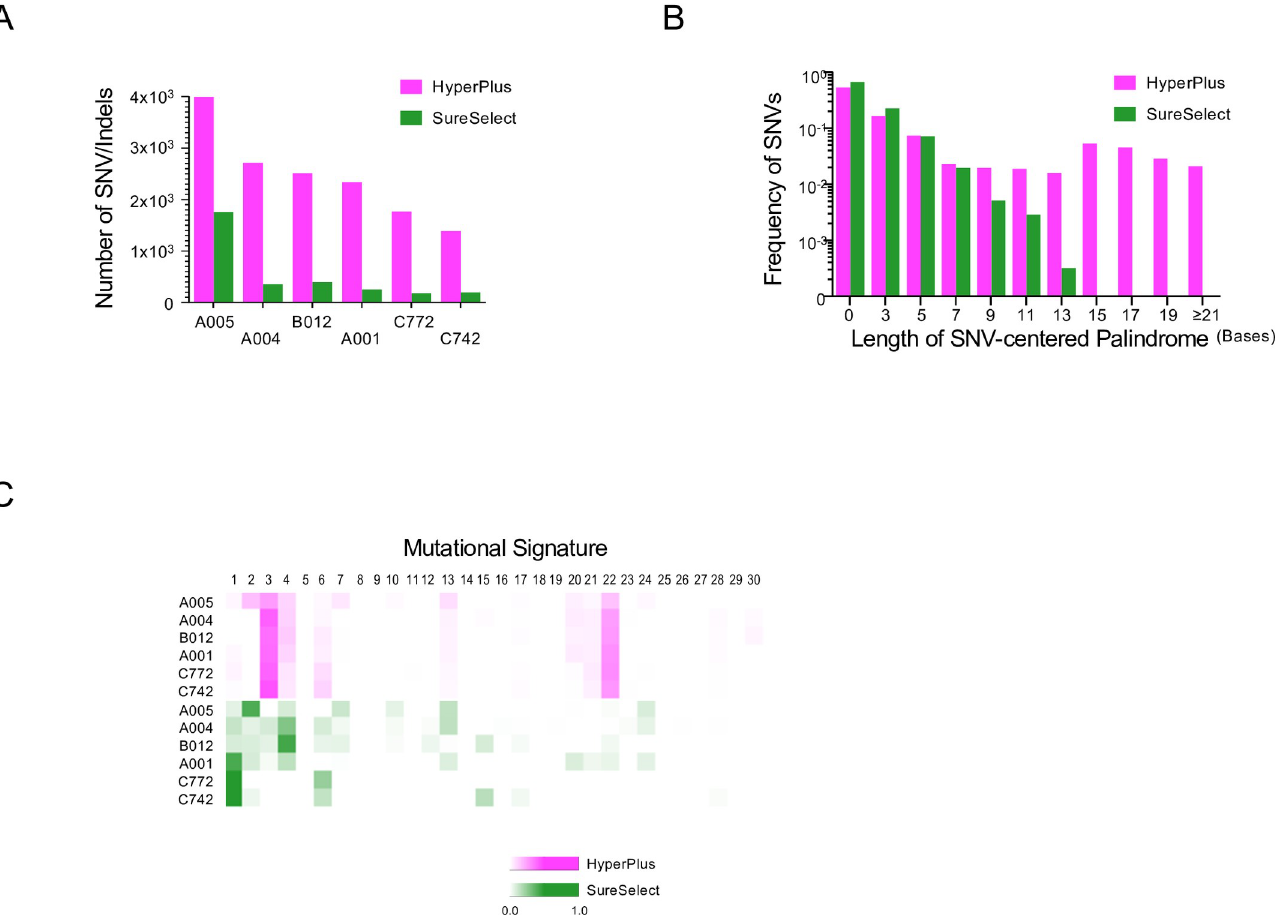
Fig 2. Differences in the sequenced results using the HyperPlus kit versus the SureSelect kit. For each sample, the same DNA was sequenced with the two different kits: HyperPlus (magenta) and SureSelect (green) kits. (A) Number of SNVs/indels. Bar plots show the number of SNVs and indels. (B) Frequency of SNVs per length of palindrome. The frequency of SNVs from all samples ( n = 6) is shown as bar plots per odd length of palindrome, in which a somatic SNV was detected at the center. The number on the x -axis indicates the total length of the palindrome. Note that a length “zero” indicates a sequence that lacks a palindrome. (C) Mutational signature heatmap. The heatmap represents the proportions of the 30 COSMIC mutational signatures [9] computed from trinucleotide frequencies of nucleotide substitutions in each sample. The number above the heatmap indicates each of the 30 signatures computed according to the definitions in the COSMIC database. Sample IDs are shown on the